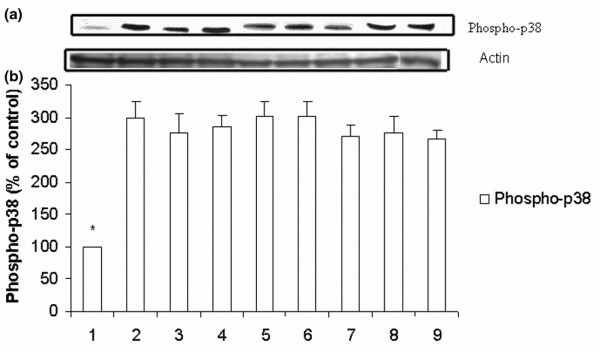
Western blot analyses of phospho-p38. (a) Representative Western blot and (b) densitometric analysis of five blots (mean ± standard error of the mean) expressed as a percentage of values for corresponding control-treated tissue samples (no ischemia or reperfusion). Groups: 1 = control, nonischemic group; 2 = ischemia/reperfusion; 3–5 = IB-MECA 50 μg/kg, 100 μg/kg, and 300 μg/kg, respectively, administered before reperfusion; 6 and 7 = MRS3558 50 μg/kg and 100 μg/kg, respectively, administered before reperfusion; 8 = MRS1191 pretreatment before MRS3558 (100 μg/kg) and beginning of reperfusion; and 9 = DMSO administration. Densitometry data presented is normalized to the intensity of actin bands. * P < 0.001 versus the other groups. DMSO, dimethyl sulfoxide.